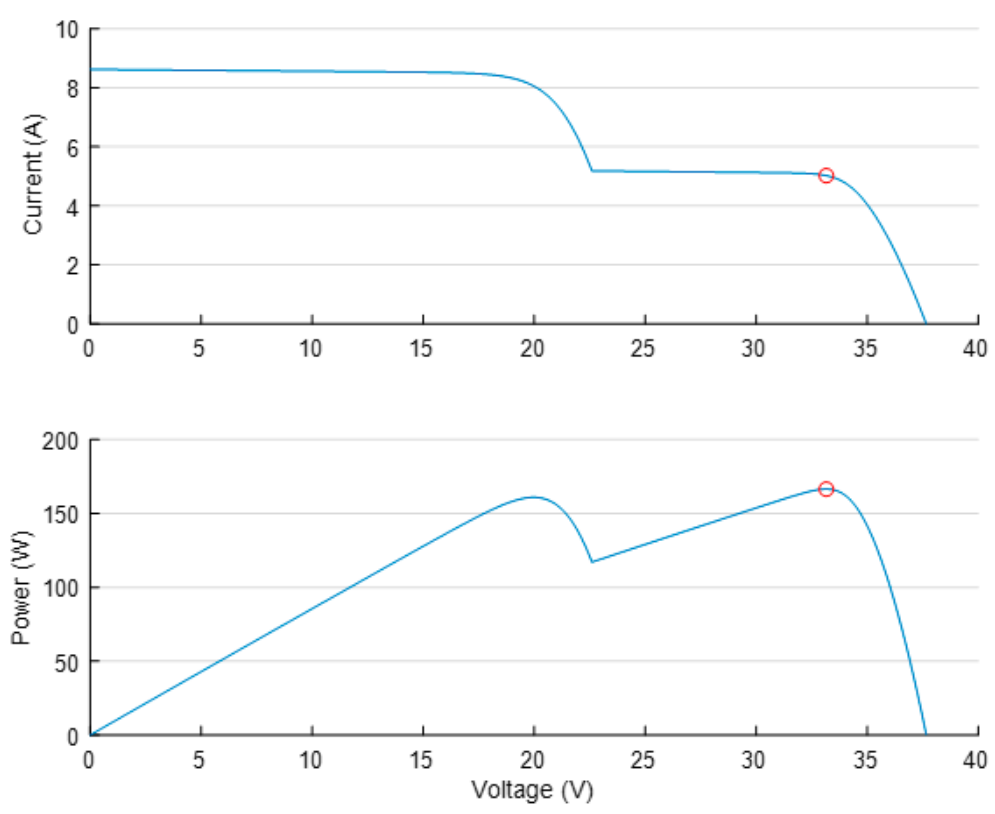
Figure 4. I-V and P-V curves of a shaded PV module with one bypass diode